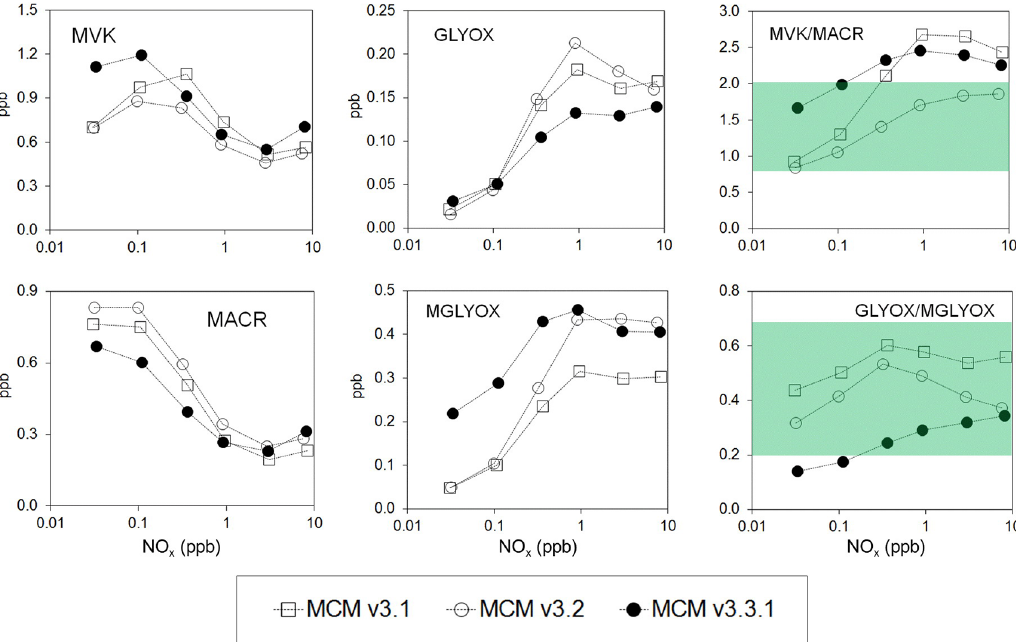
Figure 15. Comparison of the performances of MCM v3.1, MCM v3.2 and MCM v3.3.1, showing the NO x dependence of the daylight- averaged mixing ratios of MVK, MACR, glyoxal (GLYOX) and methylglyoxal (MGLYOX); and the daylight-averaged ratios, MVK / MACR and GLYOX / MGLYOX. The shaded bands in the MVK / MACR and GLYOX / MGLYOX panels represent the typical ranges of reported observed values in isoprene-dominated environments (see